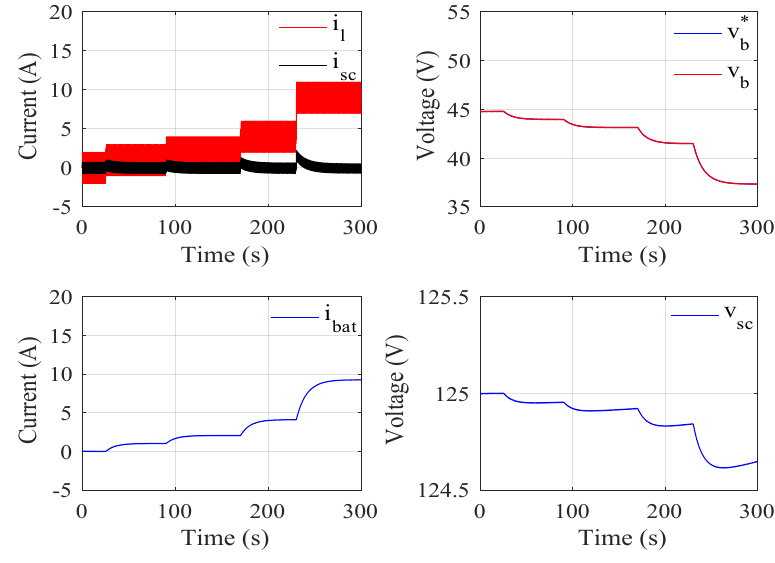
Figure 10. Simulation results: 65%